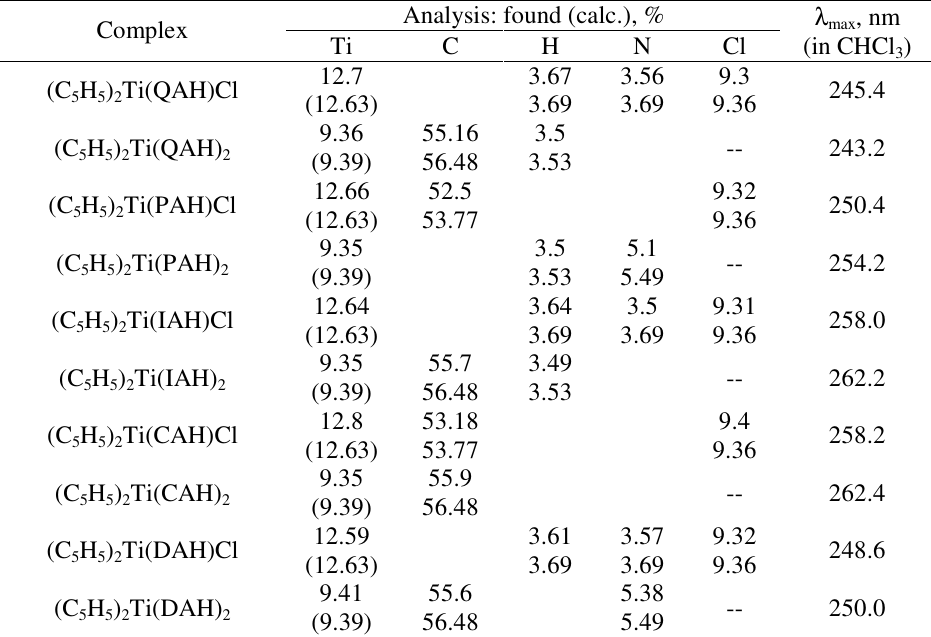
Table 2. Characterization